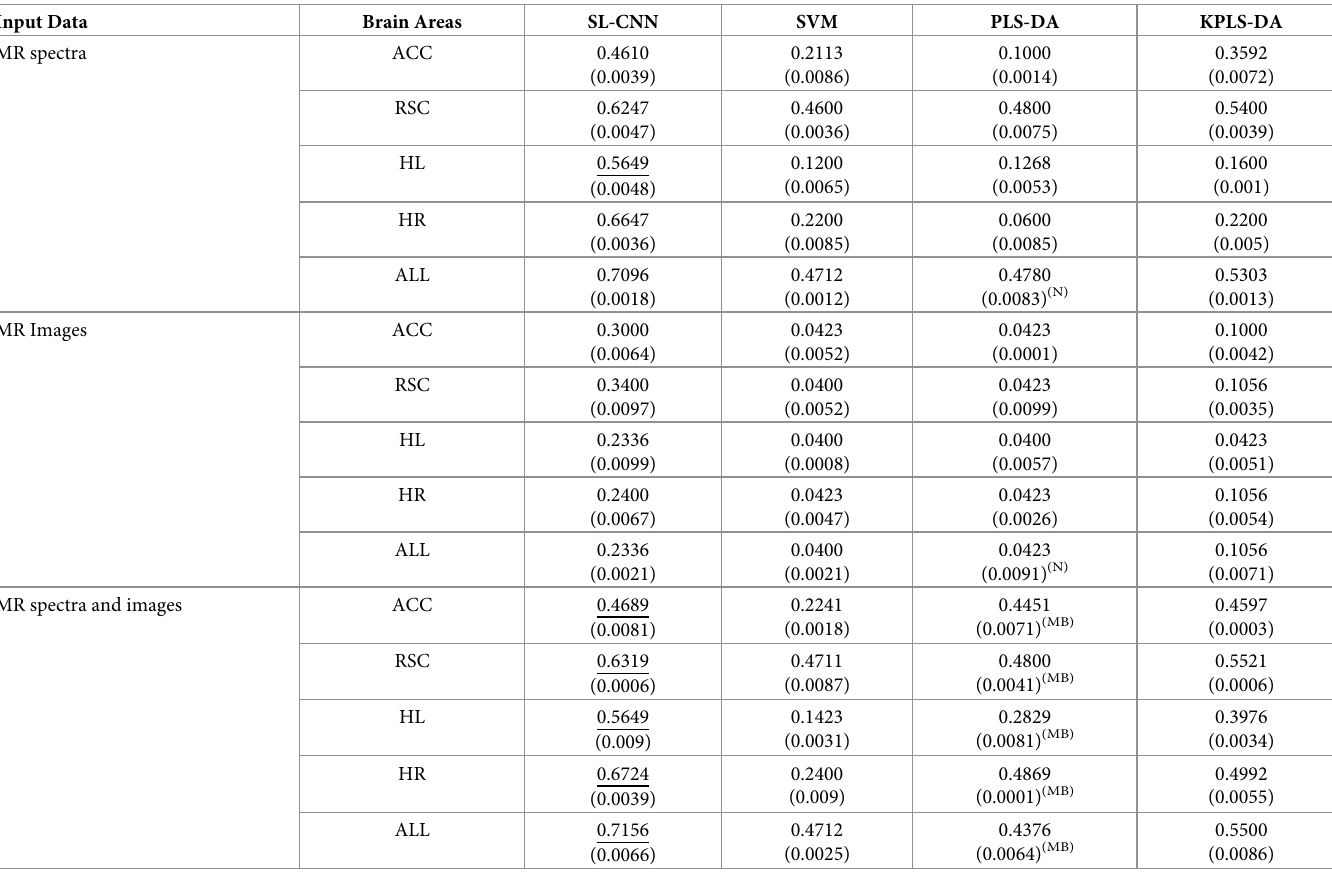
Table 4. Average classification MCC score assessed by LOPO-CV to separate Alzheimer’s disease patients (31) from healthy controls (31). (N) steads for NPLS-DA (PLS-DA for tensor data), (MB) steads for MBPLS-DA (PLS-DA for data with multiple types). Standard deviation is reported below each score between brackets. The best results are